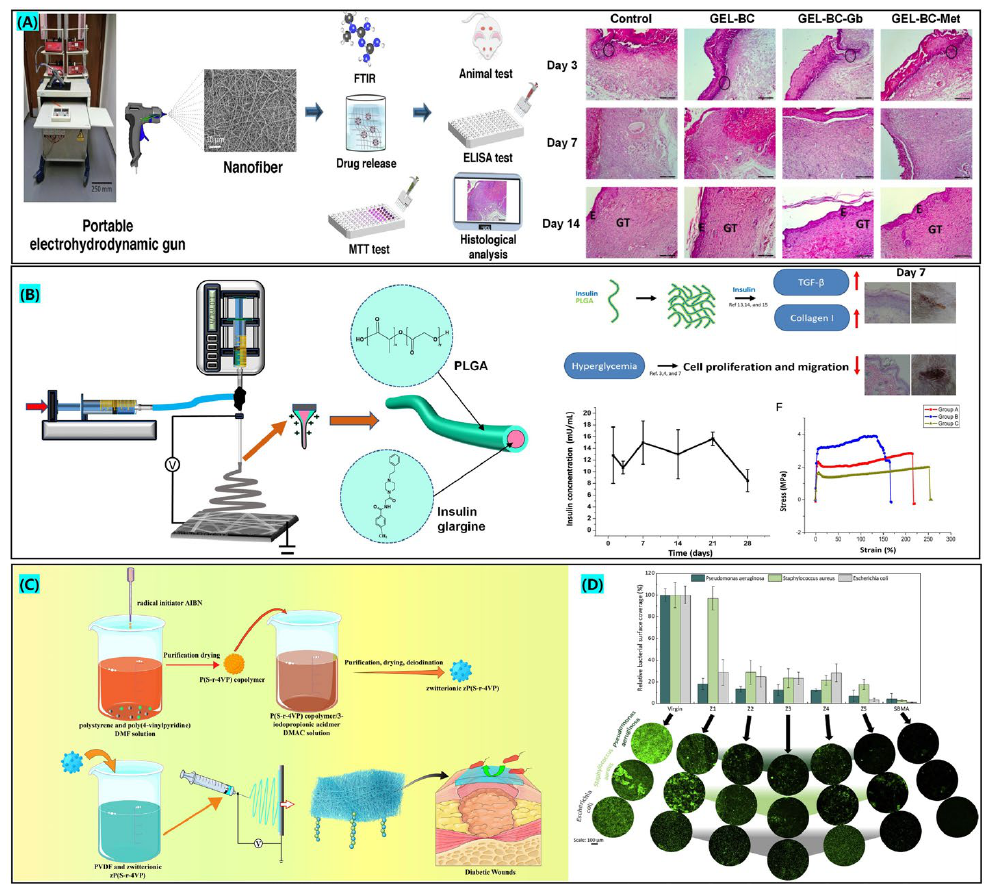
Figure 6. ( A ). Preparation of “all-natural” diabetic wound dressing by portable electrospinning, ap-